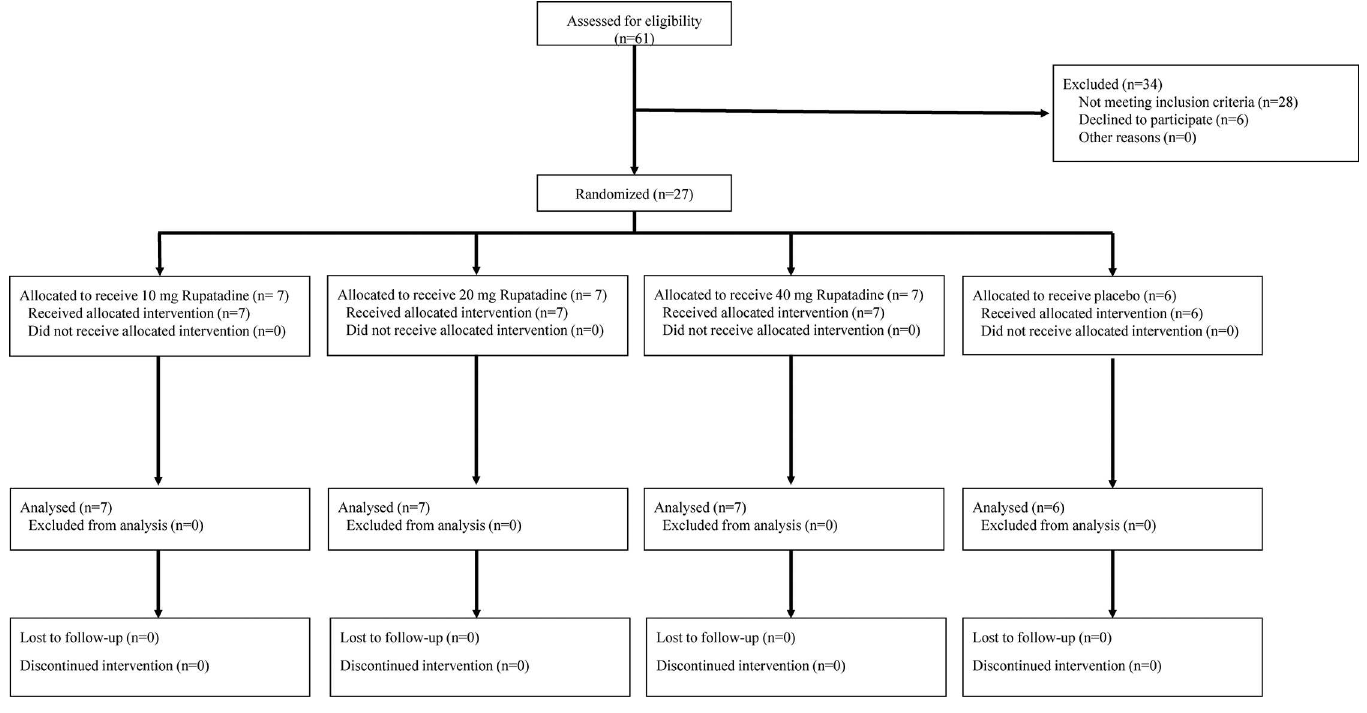
Fig 2. CONSORT 2010 Flow Diagram. Outlineddesign of the clinical study.